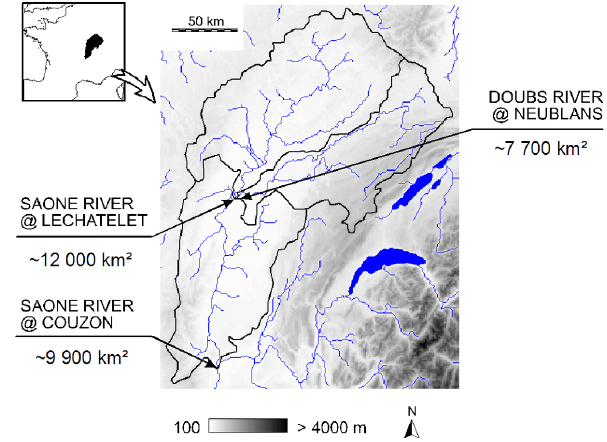
Fig. 1. Location of the Saˆone river basin divided into three sub-